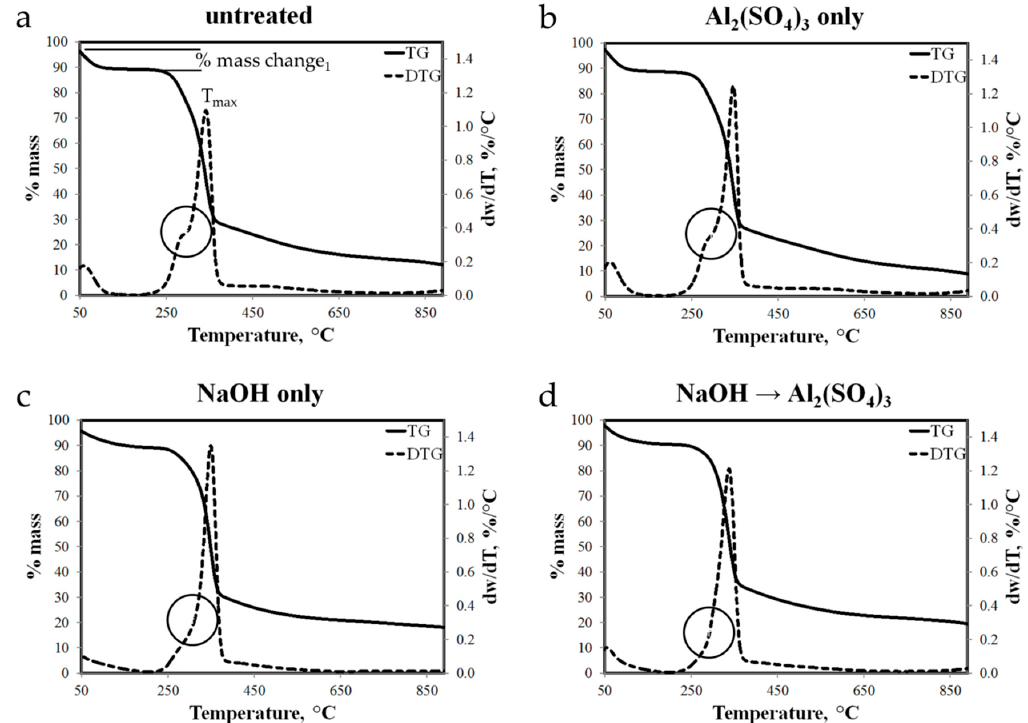
Figure 11. Thermograms of: ( a ) untreated; ( b ) treated solely with Al 2 (SO 4 ) 3 ; ( c ) alkali-pretreated; and ( d ) alkali and Al 2 (SO 4 ) 3 solution-treated abaca fiber samples